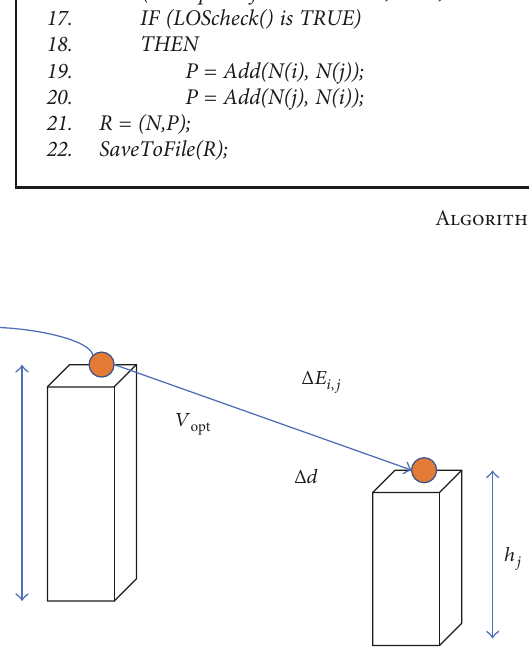
Figure 5: Energy consumption between two nodes in the visibility graph.